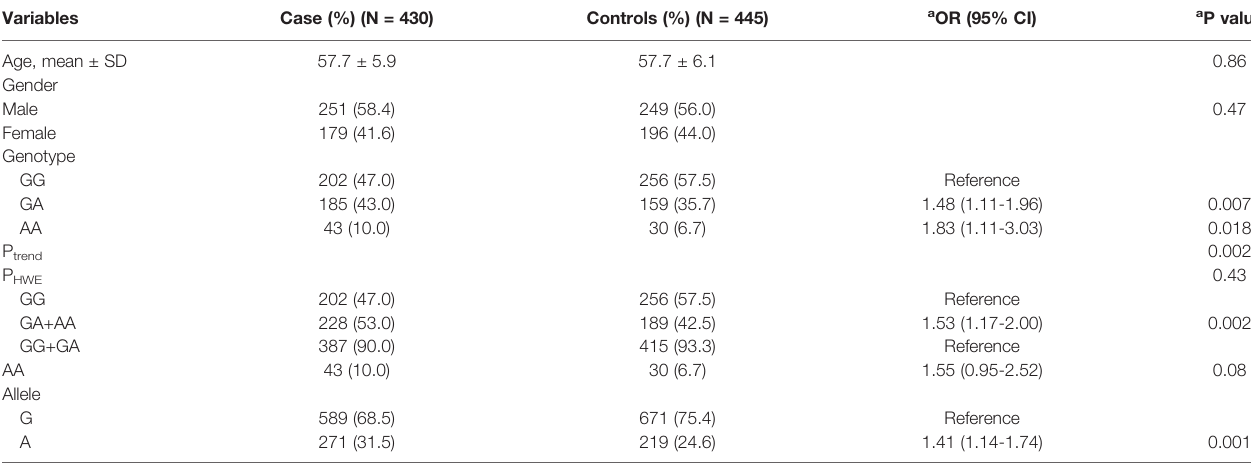
TABLE 1 | Characteristics of age, gender and rs7158663 polymorphism in cases and controls.